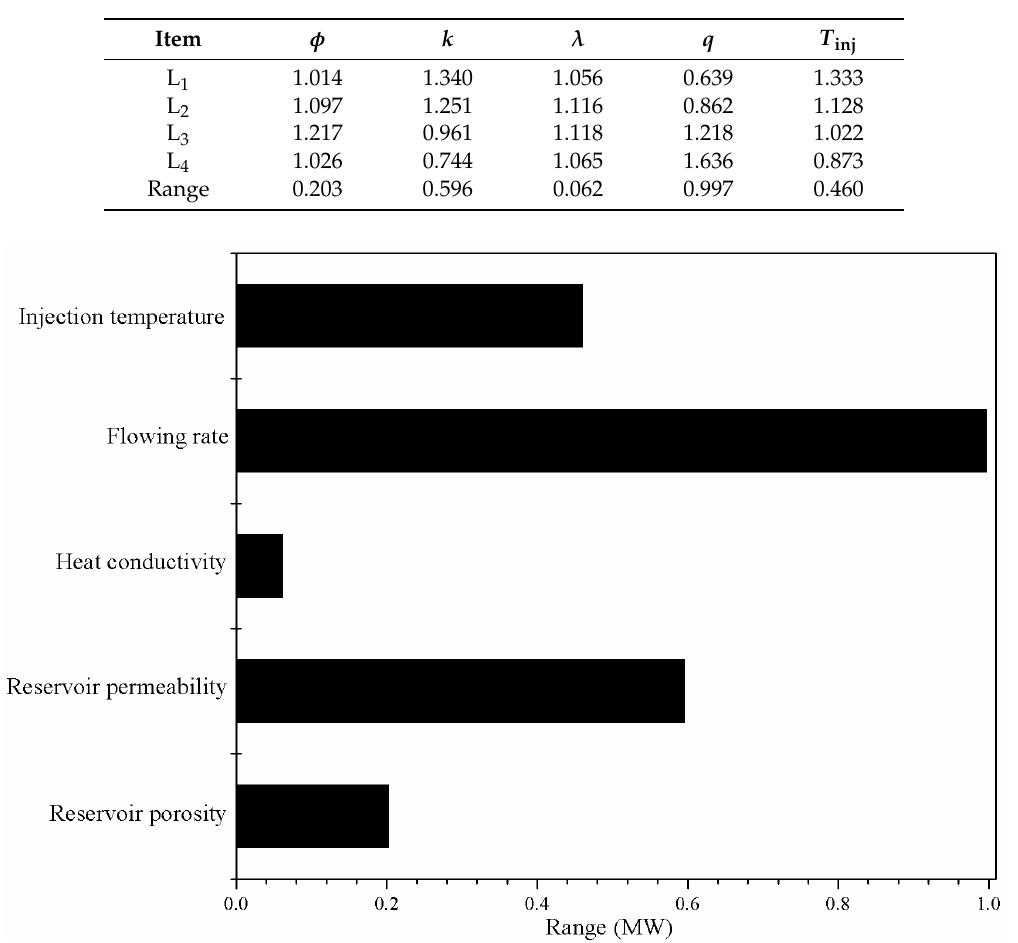
Figure 8. Ranking of the five conditions of the influential effects on the pump power.